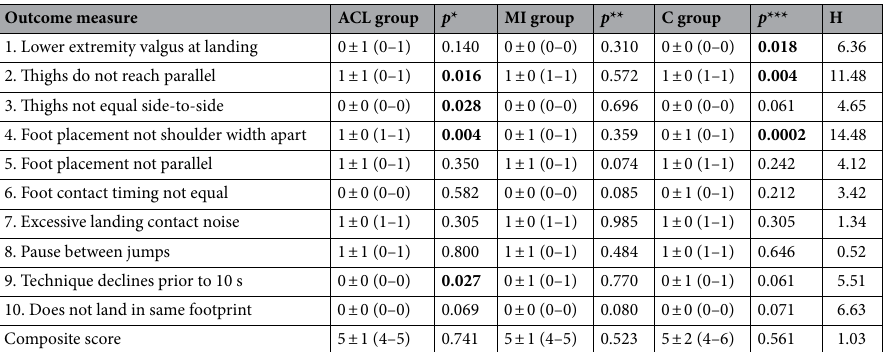
Table. 4. Comparison of Tuck Jump Assessment variables between study groups. p < 0.05 values are indicated in bold. Values are expressed as median ± quantile range (lower quantile − upper quantile) of points from TJA test. H, Kruskal–Wallis test value between study groups. p * p value between ACL group and C group (the p value there is the post-hoc of study groups main effect). p ** p value between MI group and C group (the p value there is the post-hoc of study groups main effect). p *** p value between ACL group and C group (the p value there is the post-hoc of study groups main